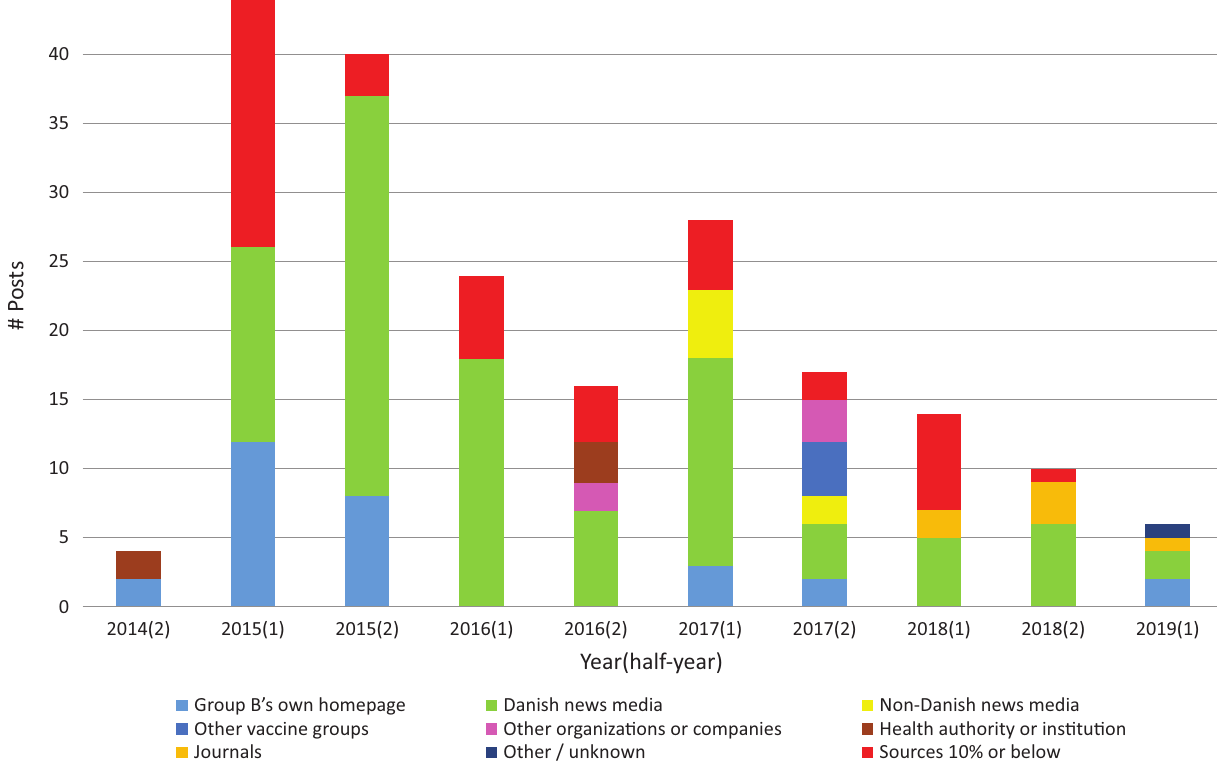
Figure 4. Sources of information on Page B until May 2019. Note: See also additional information in caption to Figure 3. Media and Communication, 2020, Volume 8, Issue 2, Pages